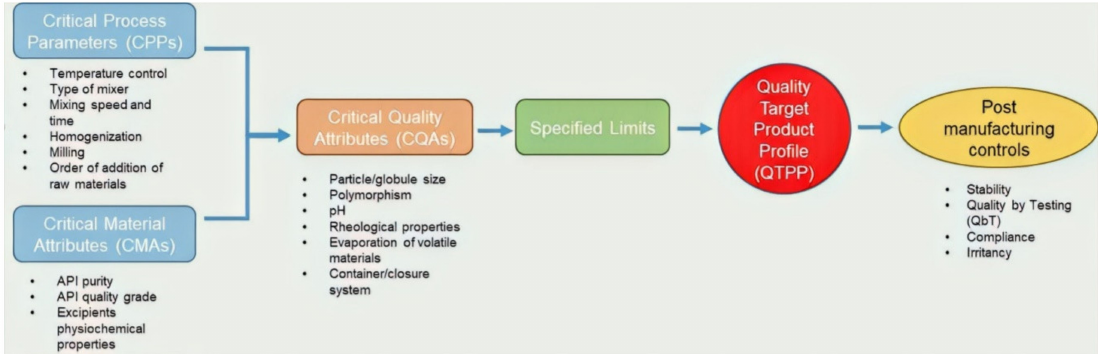
Figure 1. The quality by design (QbD) approach for the development of topical semisolid products. critical process parameters (CPPs) and critical material attributes (CMAs) govern the individualized QTPP for a product.